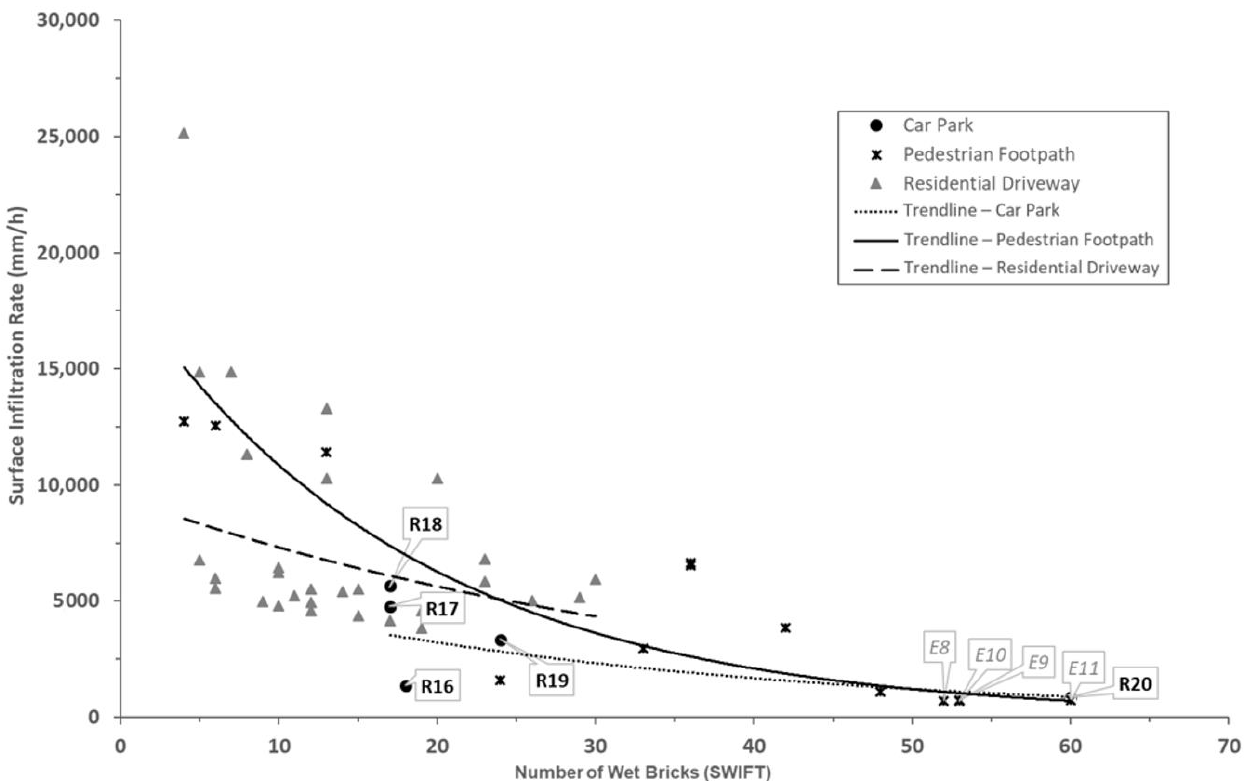
Figure 5. Infiltration rate of pavers under different usage.